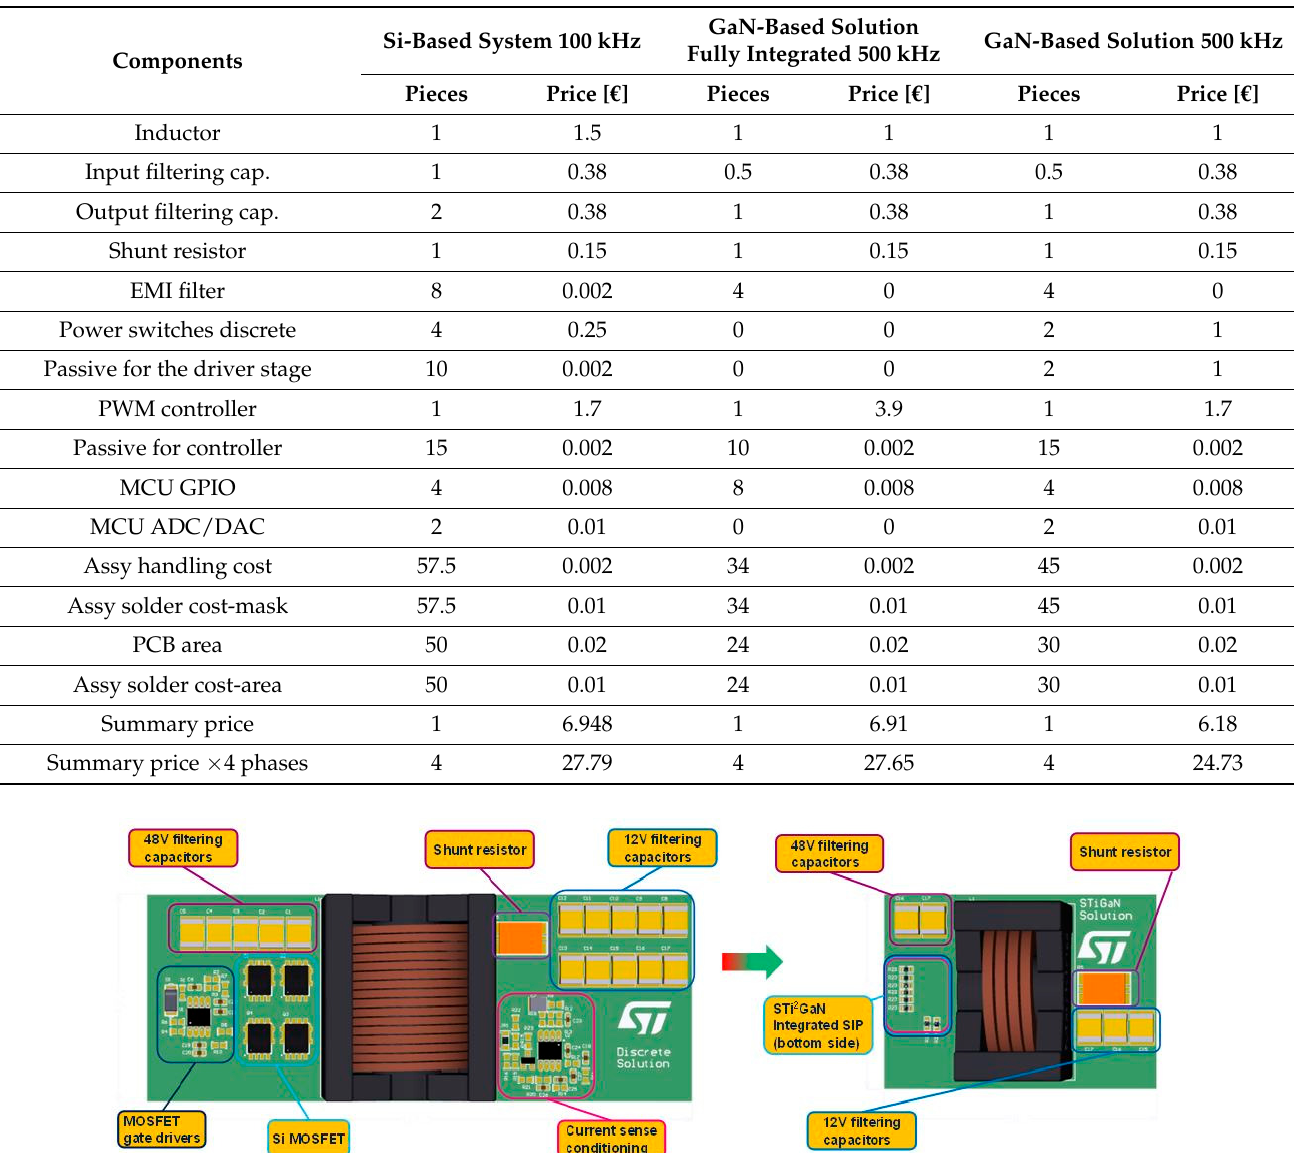
Table 1. Cost comparison of passives used in Si- and GaN-based power electronics converters adopted in an electric vehicle.